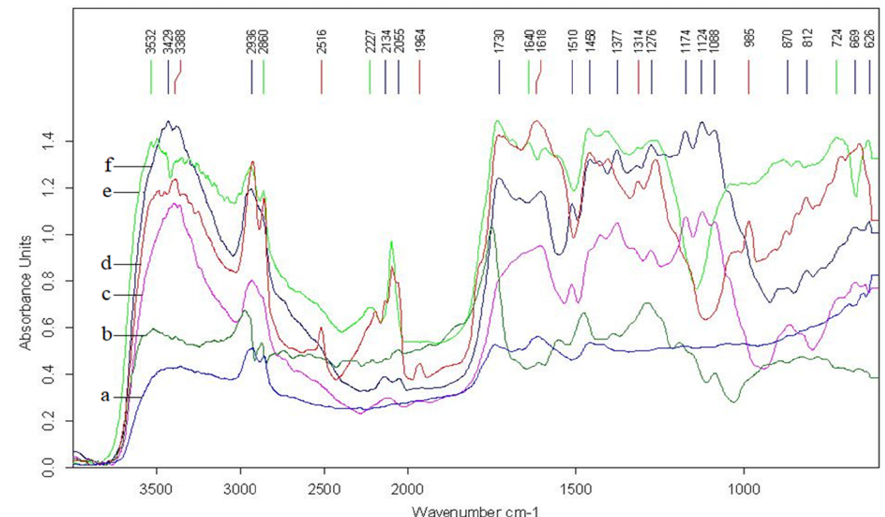
Figure 17. FT-IR spectrum for a series of samples analyzed by SEM-EDX: a—preparation layer (S), b—varnish (V), c—red (R), d—blue (B), e—yellow (Y), f—white (W). Table 2. Representative peaks and spectral bands of the ions identified in the samples analyzed by